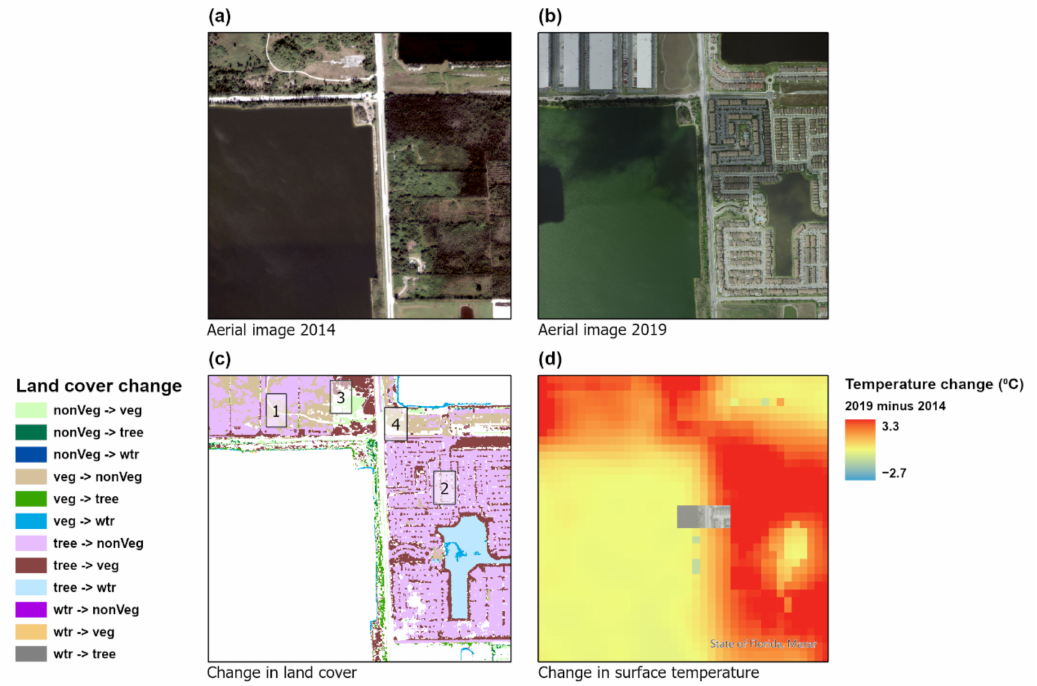
Figure 7. Land cover transition and surface temperature change for a development in Hialeah: ( a ) Forested areas present in 2014; ( b ) Commercial and residential development (2019) replacing most forested areas; ( c ) Land cover transition map; ( d ) Change in surface temperature between 2014 and 2019 (background map credits: State of Florida,